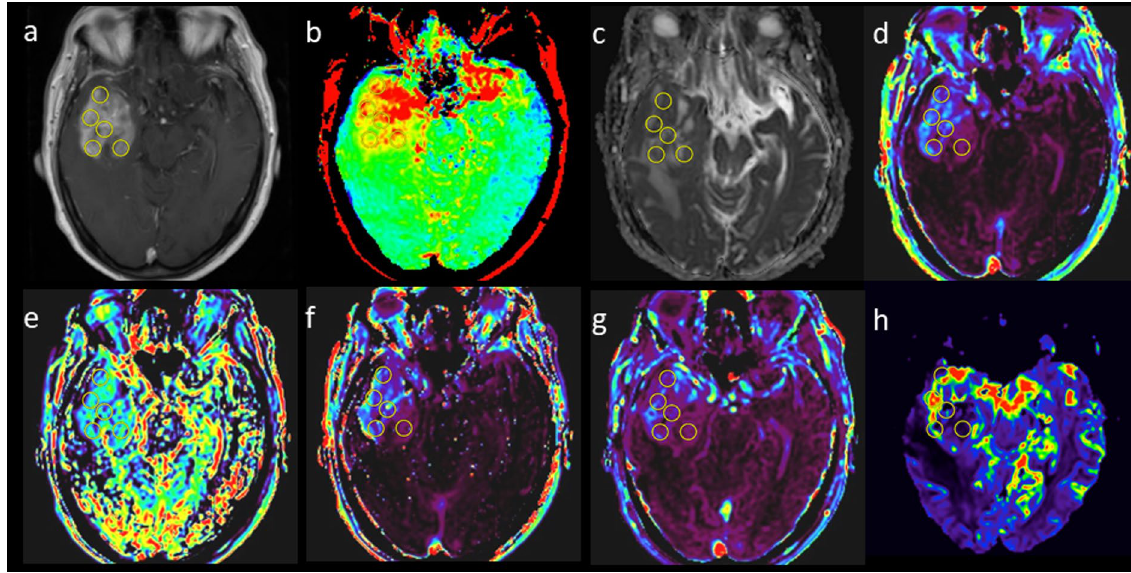
Figure 1. Region-of-interest (ROI) measurements in a 68-year-old female with glioblastoma. Round ROIs with a diameter of 10 mm are placed to fill the solid enhancing part of the tumor on contrast-enhanced T1-weigted image ( a ). The ROIs were copied onto maps of APTSI ( b ), ADC ( c ), K trans ( d ), k ep ( e ), v e ( f ), v p ( g ), and rCBV ( h